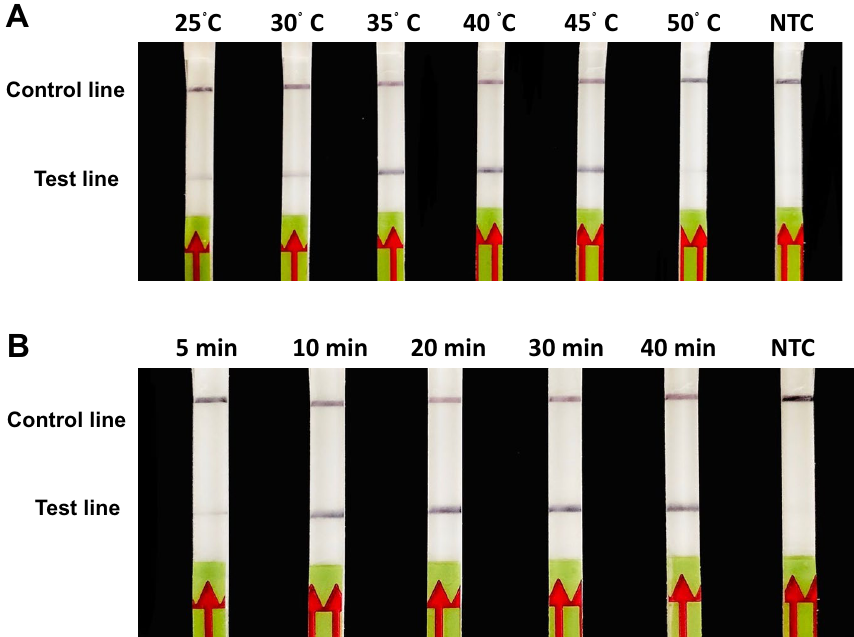
Figure 3. Optimization of the RPA amplification reaction temperature and time. ( A ) Evaluation of different reaction temperatures from 25 to 50 °C. ( B ) Evaluation of different reaction times between 5 and 40 min. Non- template control (NTC) represents the reaction without DNA templates using distilled water.